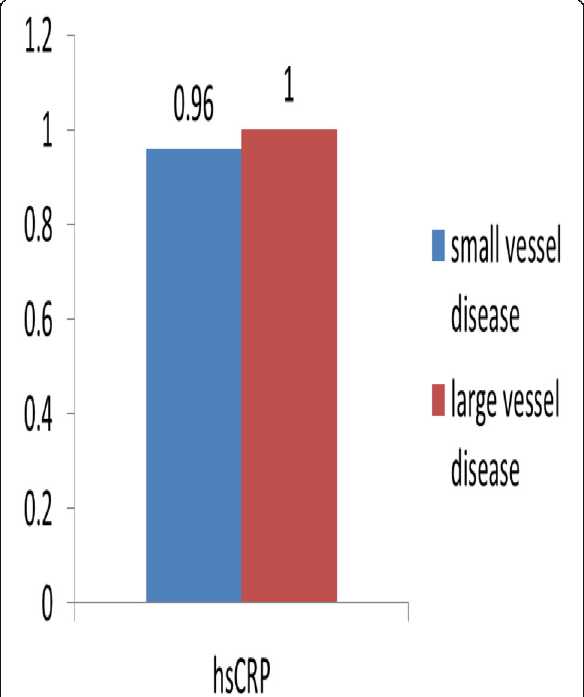
Fig. 2 Comparison between patients with large and small volumes regarding hs-CRP value. Comparison between Hs-CRP value and large vessel stroke and small vessel stroke was done, and it was found that mean CRP was slightly higher in large vessel stroke with mean 1 mg/dL ± 0.91 while 0.96 mg/dL ± 0.93 yet it was insignificant ( P value = 0.89)